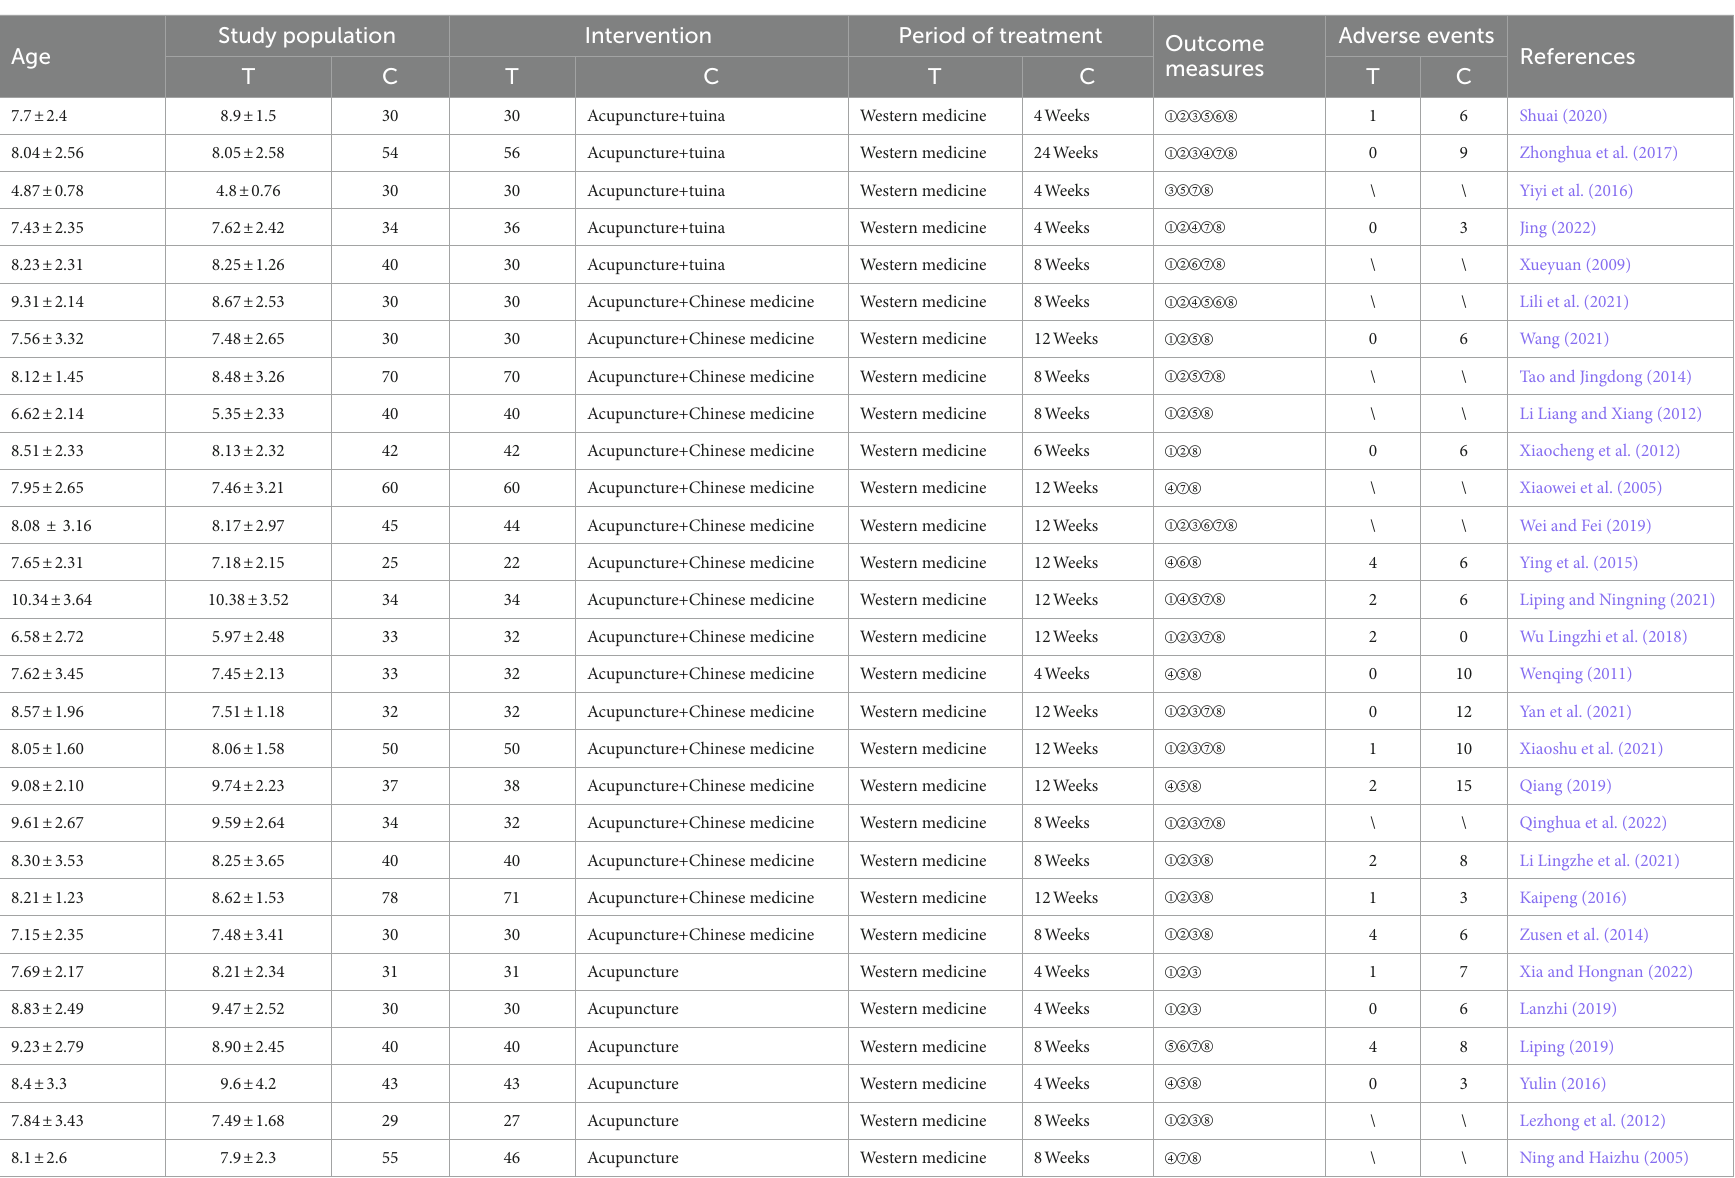
TABLE 3 Characteristics of included